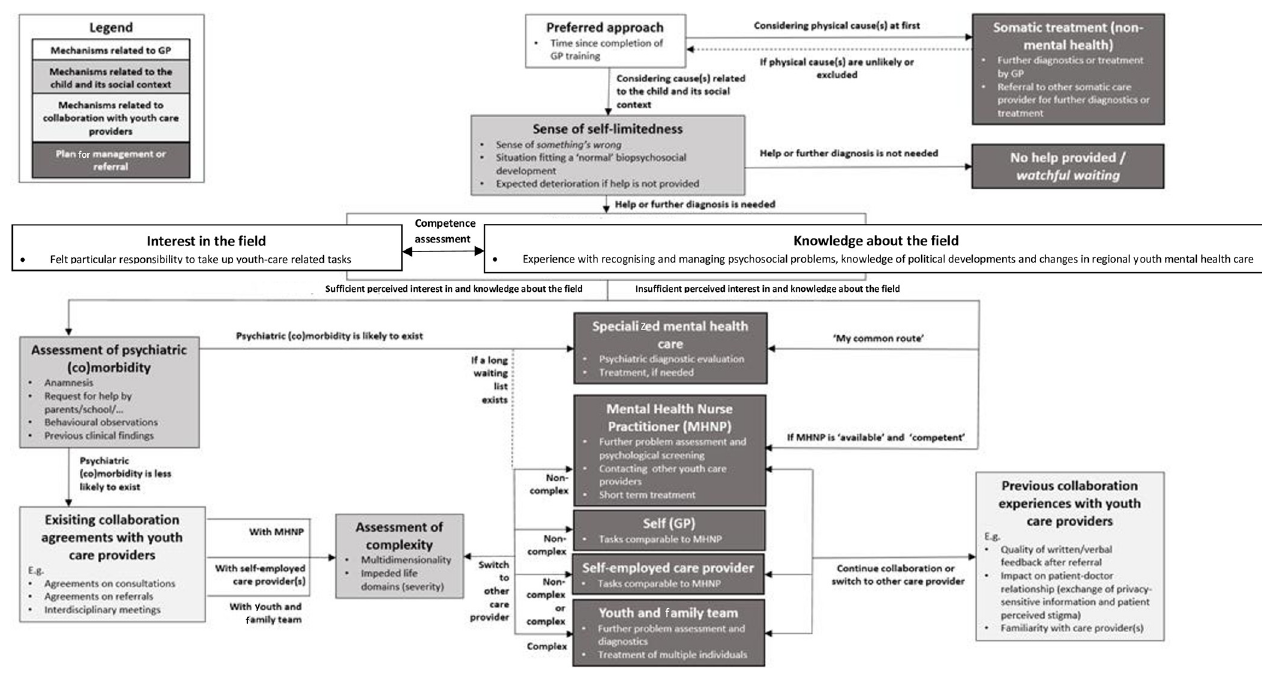
Fig 3. Flowchart of mechanisms for GPs’ everyday clinical decision-making when encountering psychosocial problems in children and youth 1,2 . 1 Presented flowchart shows GPs’ sequence of reflections and decisions when confronted with psychosocial problems in children and youths during office hours. 2 Boxes show in-depth considerations related to a specific